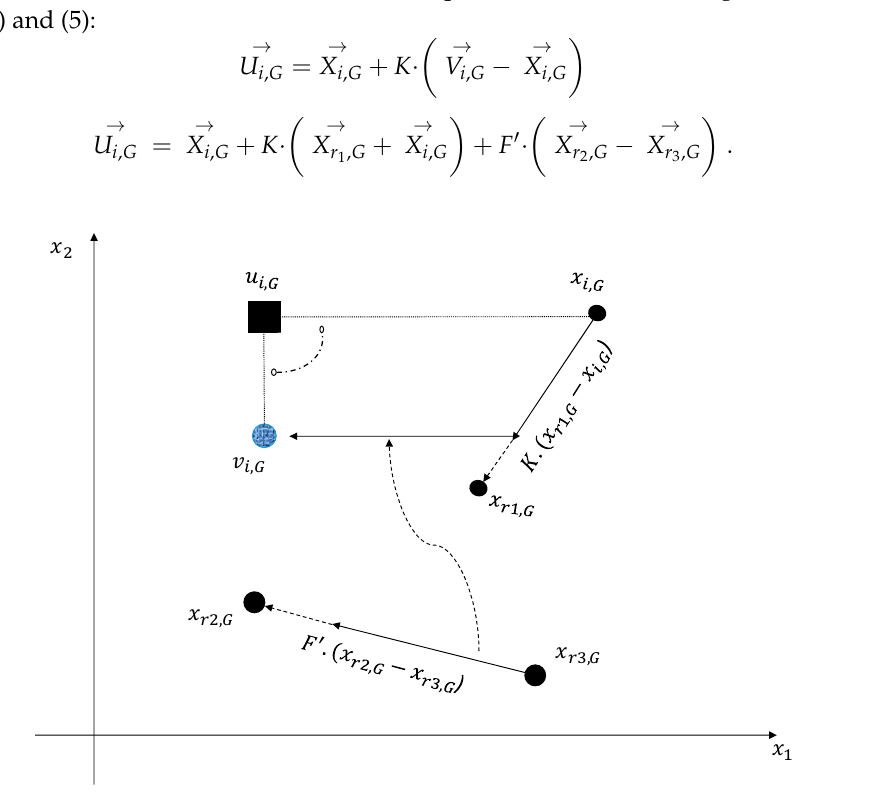
Figure 3. Process of obtaining the trial vector in the DE algorithm.